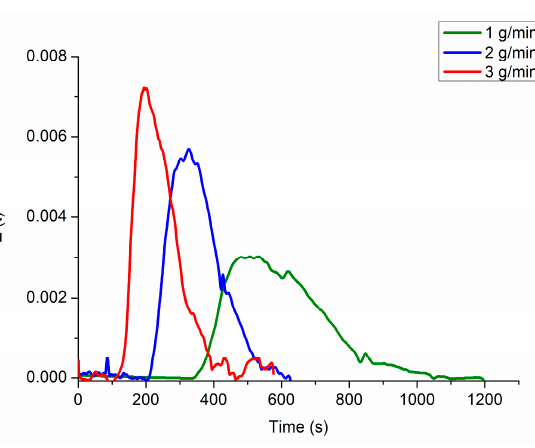
Figure 4. Residence time distributions at feed-rates of 1, 2 and 3 g/min.